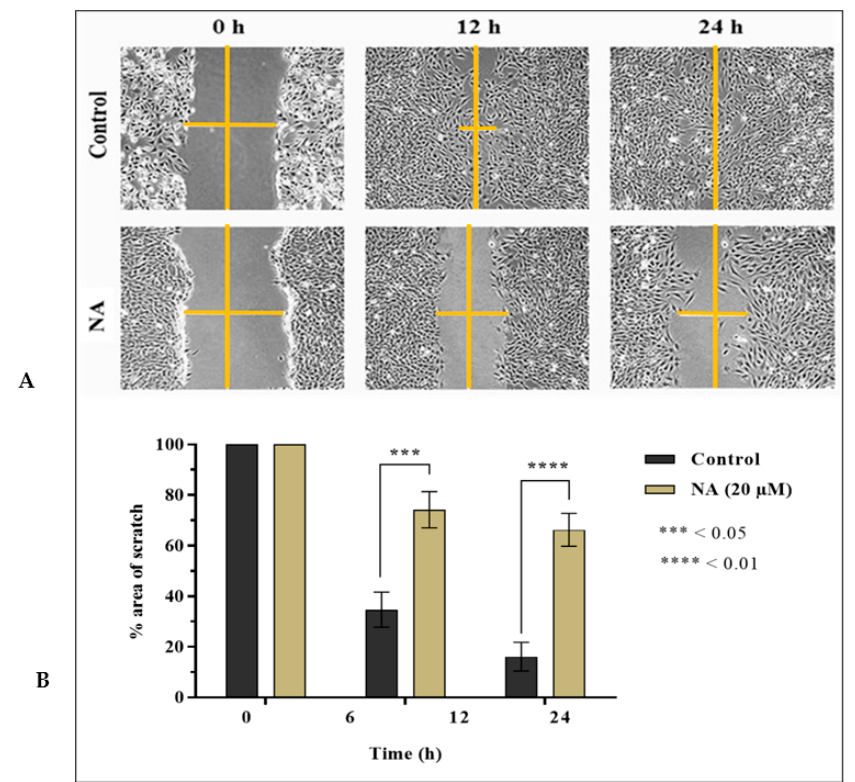
Figure 3. In vitro scratch assay on NA-treated prostate cancer cells. Note: DU145 cells were plated in 6-well plates and scratched at full confluency. ( A ) Migration of cells to heal the area of scratch was observed at 0 h, 12 h, and 24 h after treatment. ( B ) Reduction in area of scratch was photographed using Olympus CKX41 microscope and measured using ImageJ software. Data are mean ± SEM percent area of scratch in triplicate with a marked difference at p < 0.05 and p < 0.01.